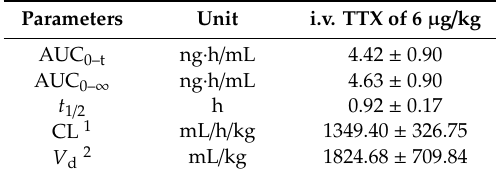
Figure 7. Mean plasma concentration-time profiles of TTX in rats following i.v. administration of TTX injection at 6 µ g / kg body wt. (red curve) and i.g. administration of sustained-release TTX pellets at 150 µ g / kg body wt. (blue curve) ( n = 6, mean ± SD). Table 4. Pharmacokinetic parameters of TTX in rats after i.v. TTX injection administration at 6 µ g / kg body wt. ( n = 6, mean ± SD). Reproduced from Bihong Hong et al. [16], which is licensed under